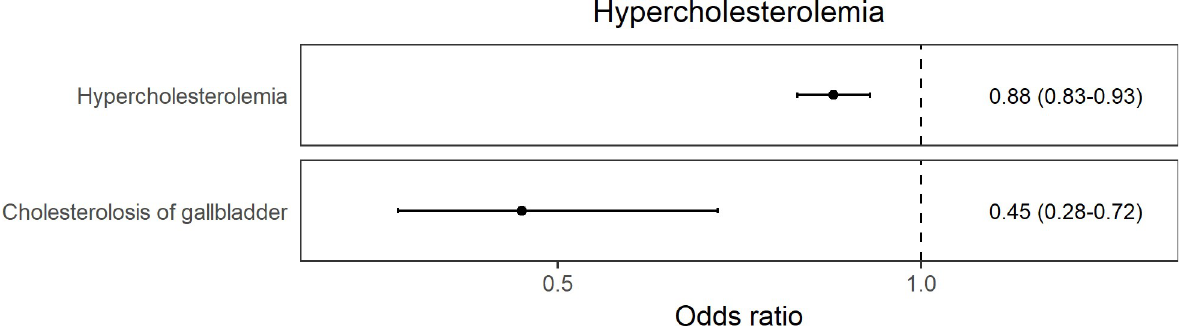
Fig 2. Forest plot of results for traits related to hypercholesterolemia for which there was evidence across the 3 genetic instruments for a causal effect of higher iron status. The ORs are reported as MR estimates corresponding to 1 SD increase in serum iron. MR, mendelian randomization; OR, odds ratio; SD, standard